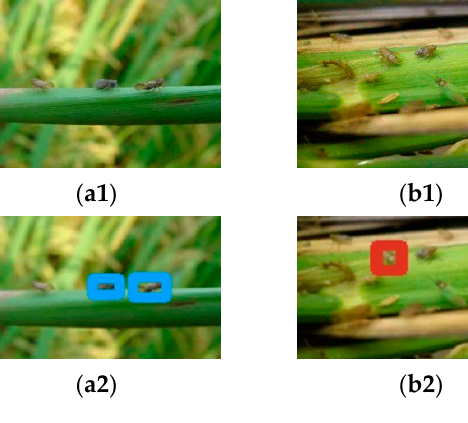
Figure 5. Rice planthopper. ( a1 ), ( b1 ), ( c1 ), and ( d1 ) are the original images; ( a2 ), ( b2 ), ( c2 ), and ( d2 ) are the recognition results.